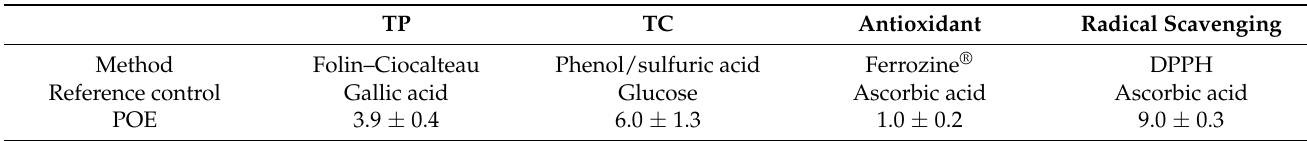
Table 1. Polyphenol and carbohydrate content in POE and its antioxidant and radical-scavenging properties. All values (mg/mL) are reported as means ± SD of at least three independent extractions. TP TC Antioxidant Radical Scavenging